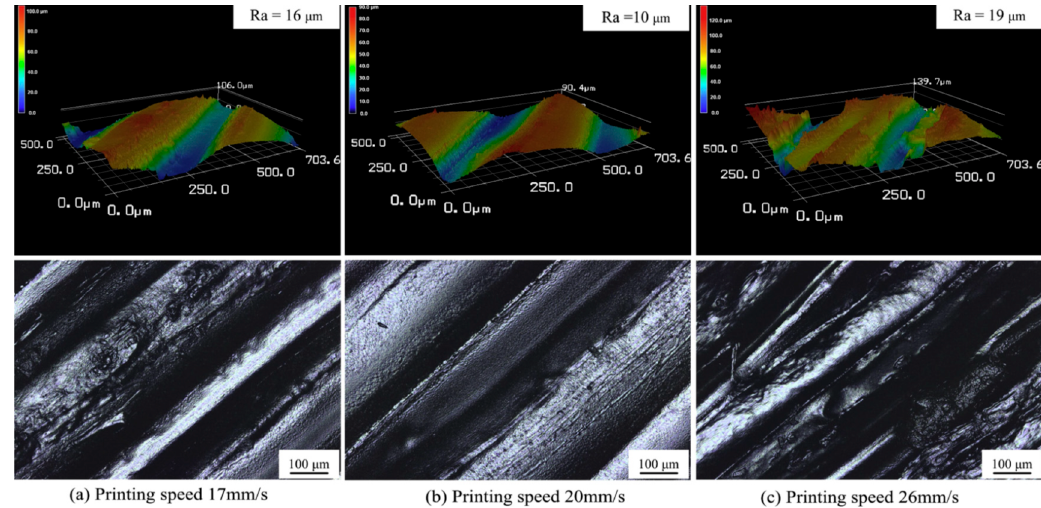
Figure 16. Surface topography of the PEEK parts printed under different printing speeds ( a ) at 17 mm/s ( b ) at 20 mm/s and ( c ) at 26 mm/s [84].